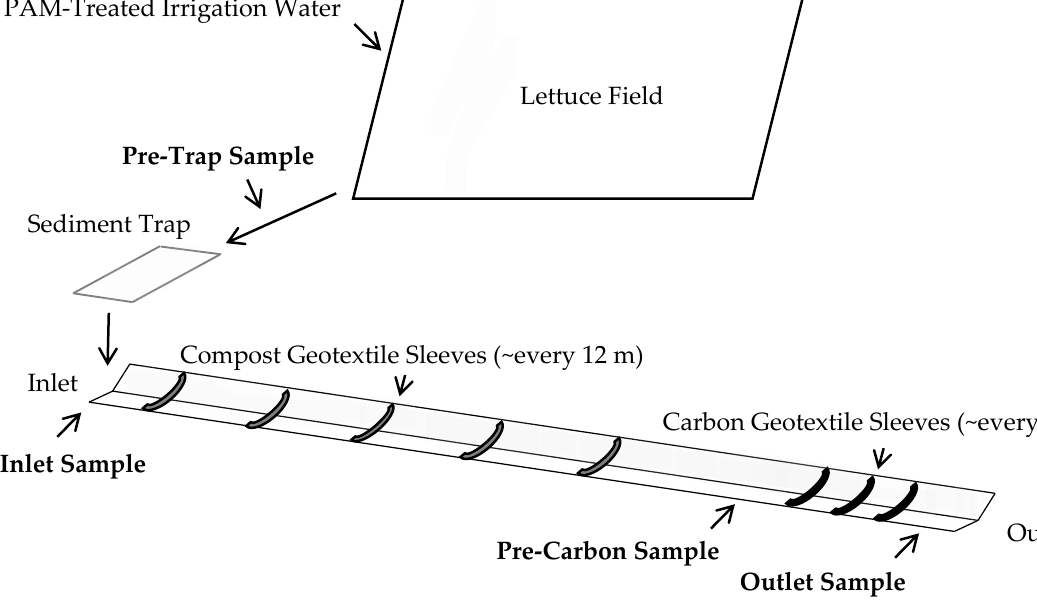
Figure 1. Schematic of ditch system (not to scale). Entire ditch was vegetated. Compost and granulated activated carbon (GAC) installations were as shown.